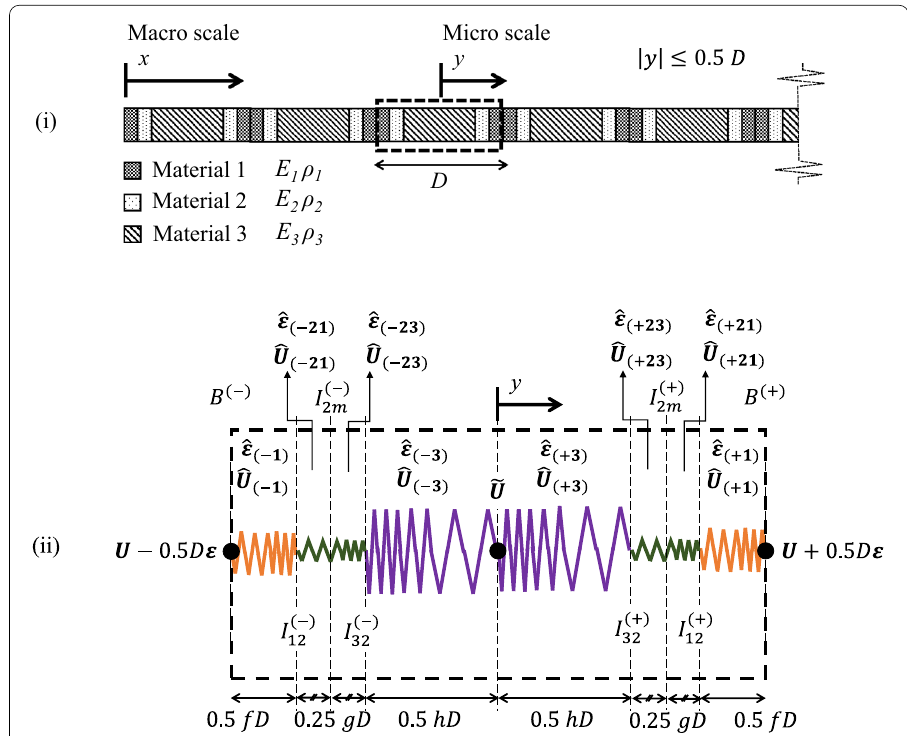
Fig. 4 i Schematics of a periodic layered composite bar with a unit cell of size D . ii The unit cell is idealised as a series of springs over eight segments. The mass of each constituent material is evenly distributed across the corresponding segment within the unit cell